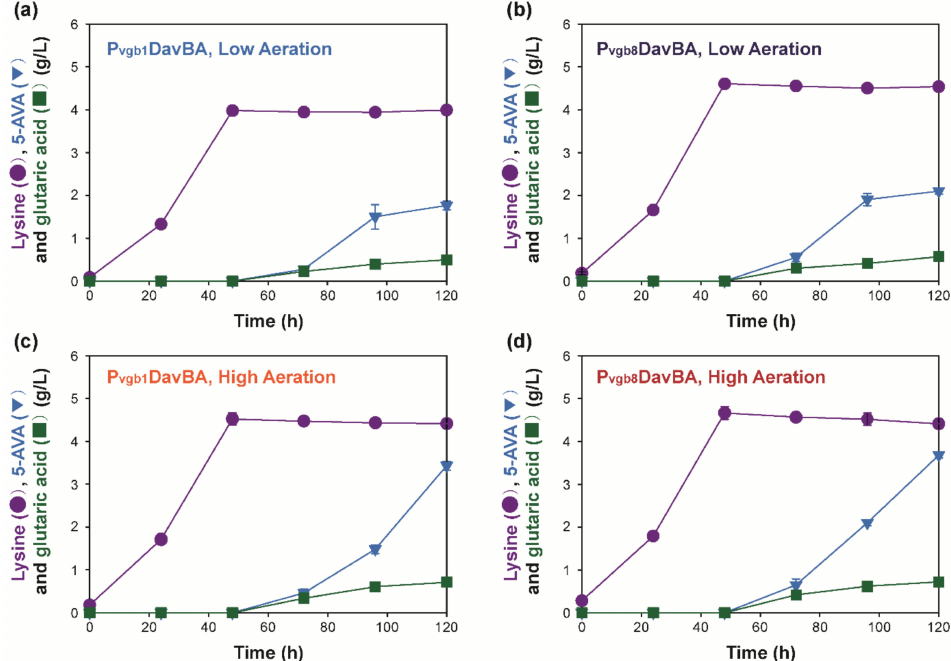
Figure 3. Time profile of 5-aminovaleric acid, L-lysine and glutaric acid production by recombinant C. glutamicum 5AVA1 ( a , c ) and 5AVA8 ( b , d ) strains under low ( a , b ) and high ( c , d )